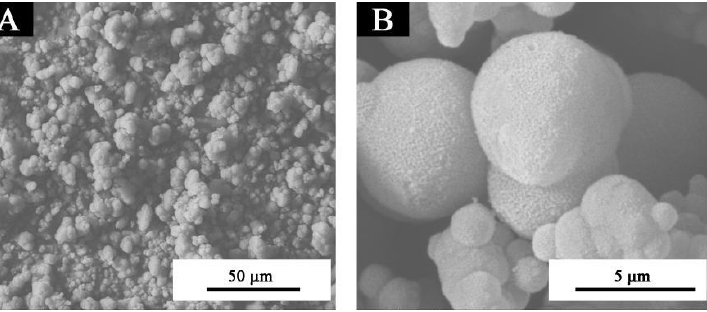
Figure 4. SEM of microcapsules of with a 0.58:1 core-shell ratio: ( A ) low and ( B ) high magnifica- tion.